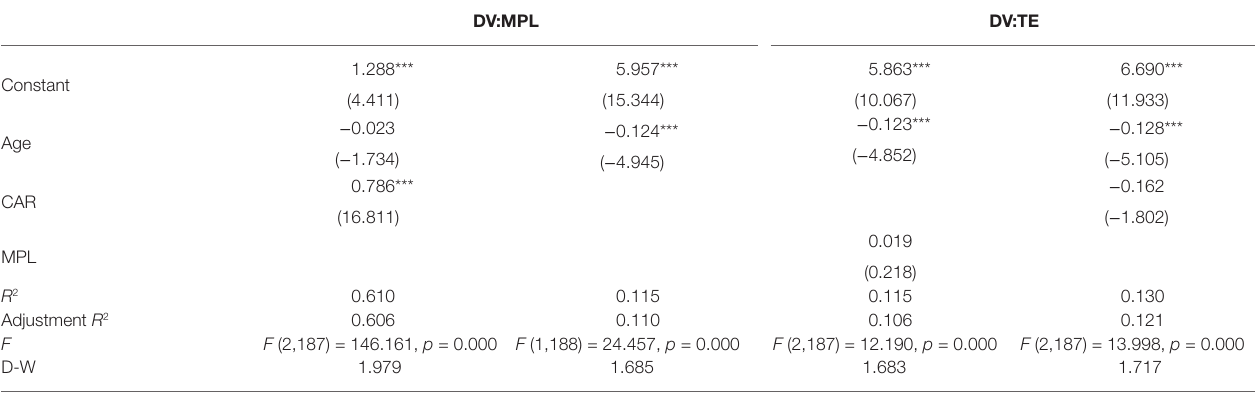
TABLE 2 | Linear regression analysis